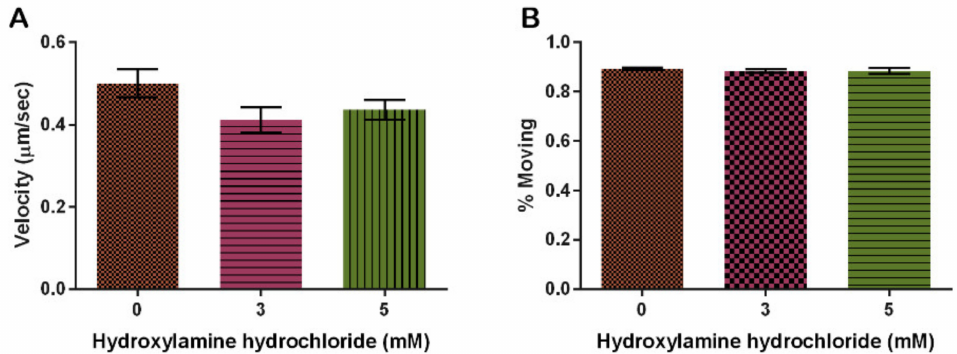
Figure 7. Effect of hydroxylamine hydrochloride on mitochondrial motility. ( A ) Increasing HA does not significantly alter velocity though it decreases slightly with increasing concentrations of HA. ( B ) Increasing HA does not alter the percentage of mitochondria moving (n = 30, p = 0.2670 and 0.1519, respectively). Columns are averages and error bars represent the standard